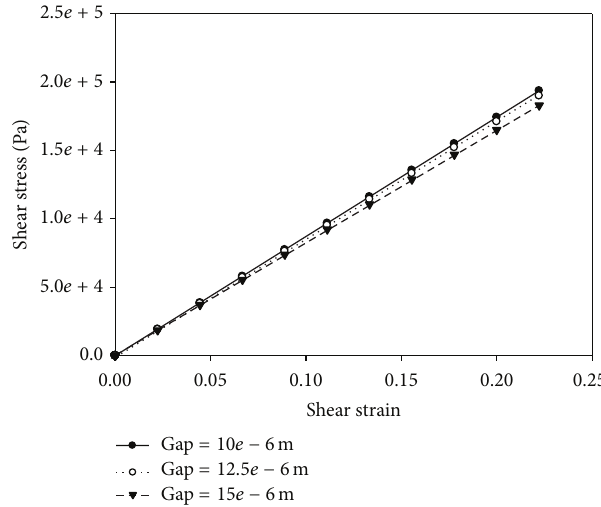
Figure 11: Different distance between two adjacent